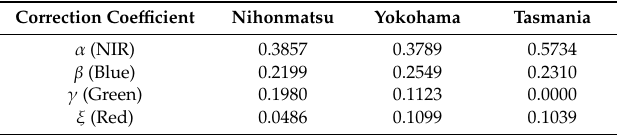
Table 3. Estimated intensity correction coe ffi